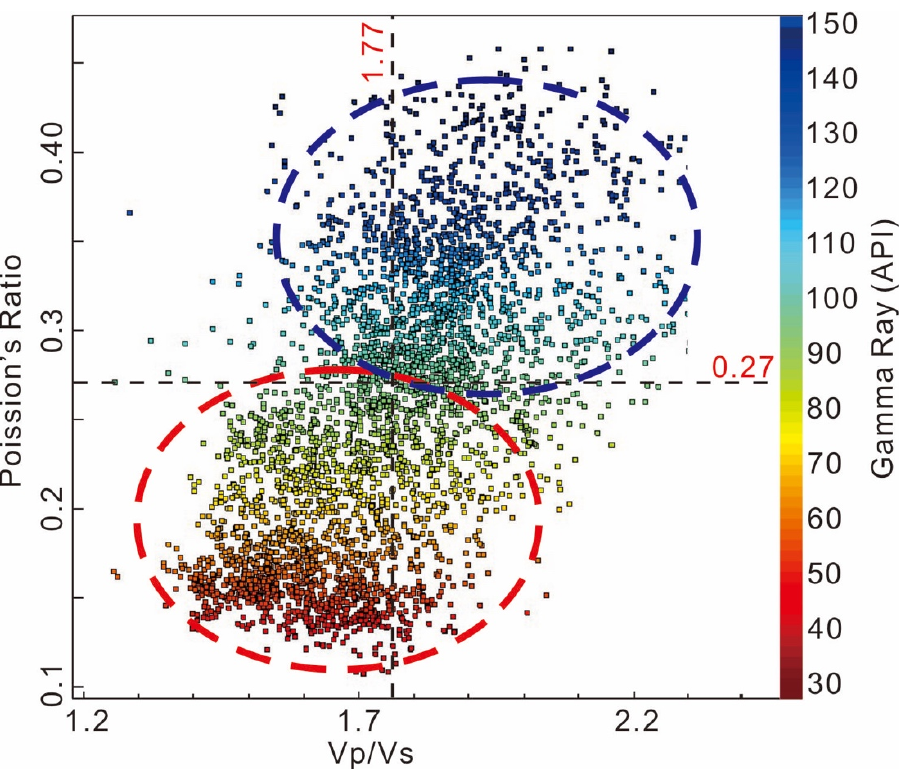
Figure 6. Cross plot of Poisson’s ratio, the Vp/Vs ratio and gamma-ray values from W-1, W-2 W-3, W-4, and W-5 well.